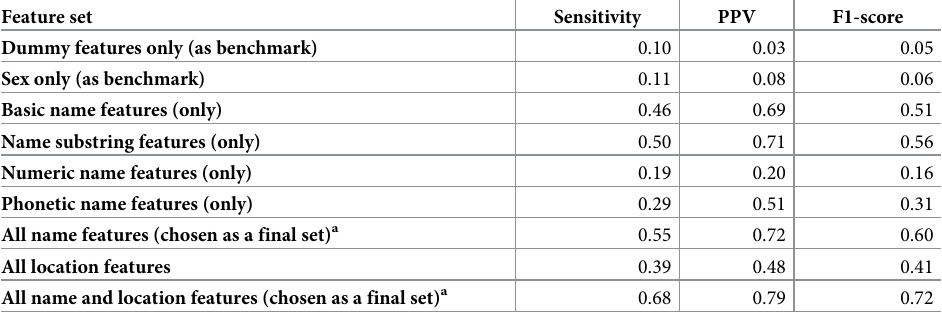
Table 2. Feature set selection result for multiclass classification using 5-fold cross-validation in development set.